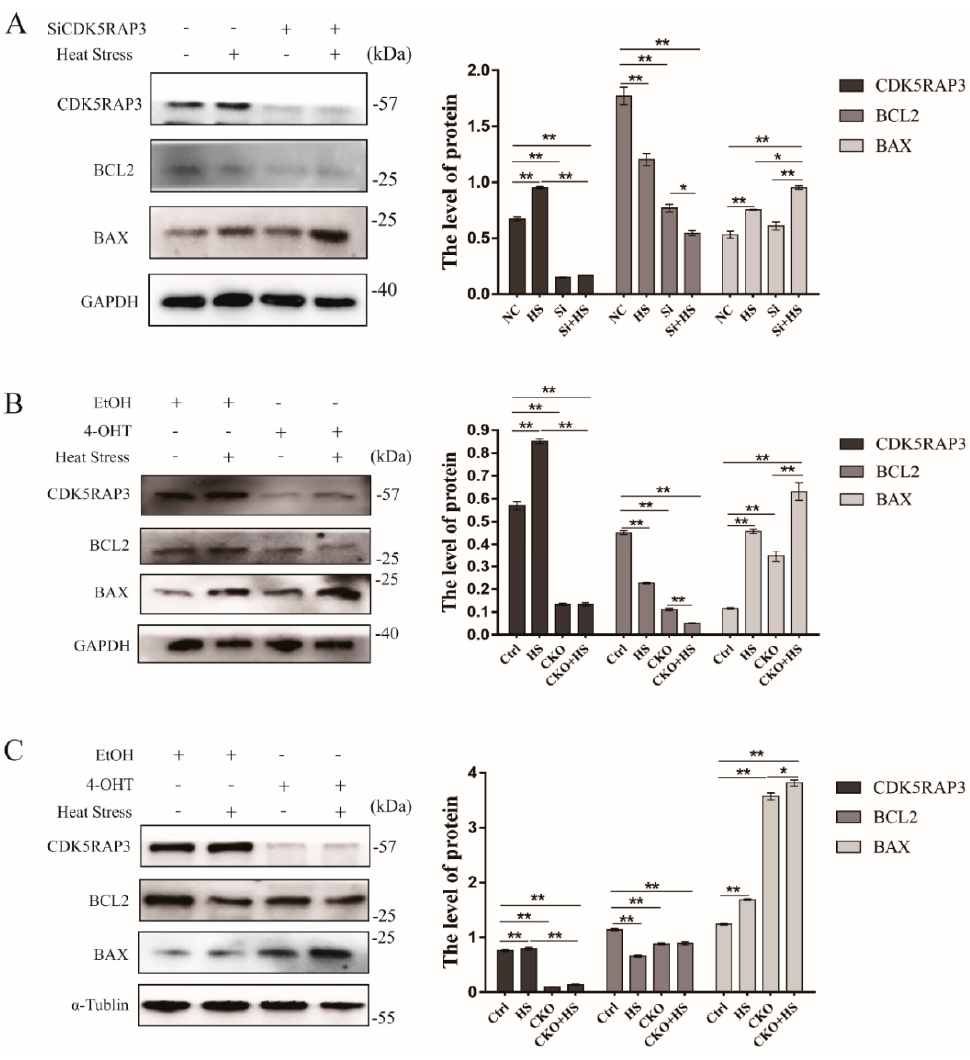
Figure 2. CDK5RAP3 induces apoptosis in bovine mammary epithelial cells, mouse fibroblasts